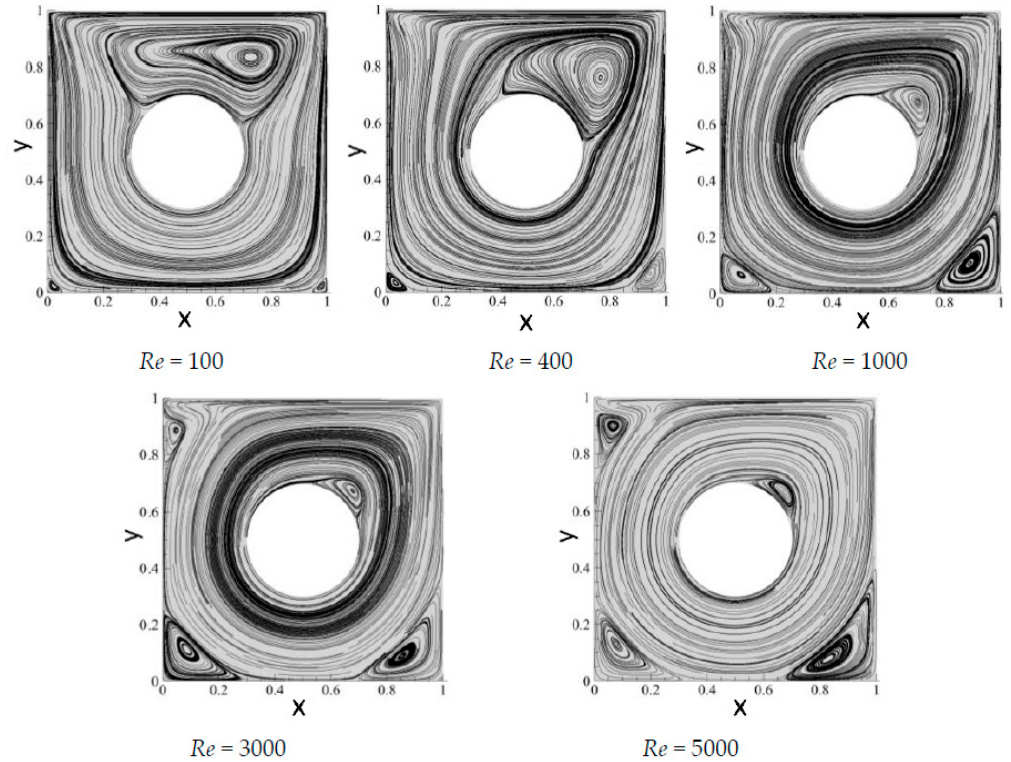
Figure 6. Streamlines of the lid-driven square cavity flow with an embedded circular obstacle at various Reynolds numbers at r = 1/5.